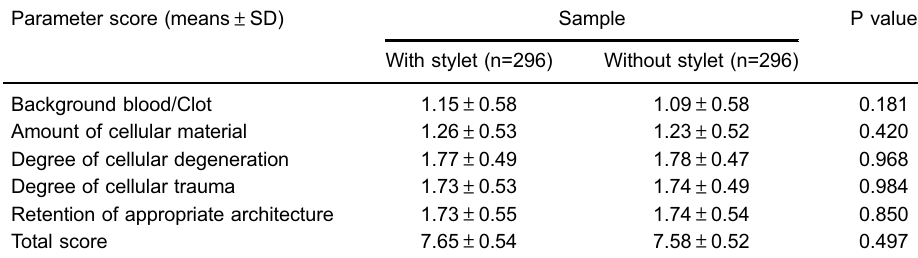
Table 3. Quality of specimens collected with or without a